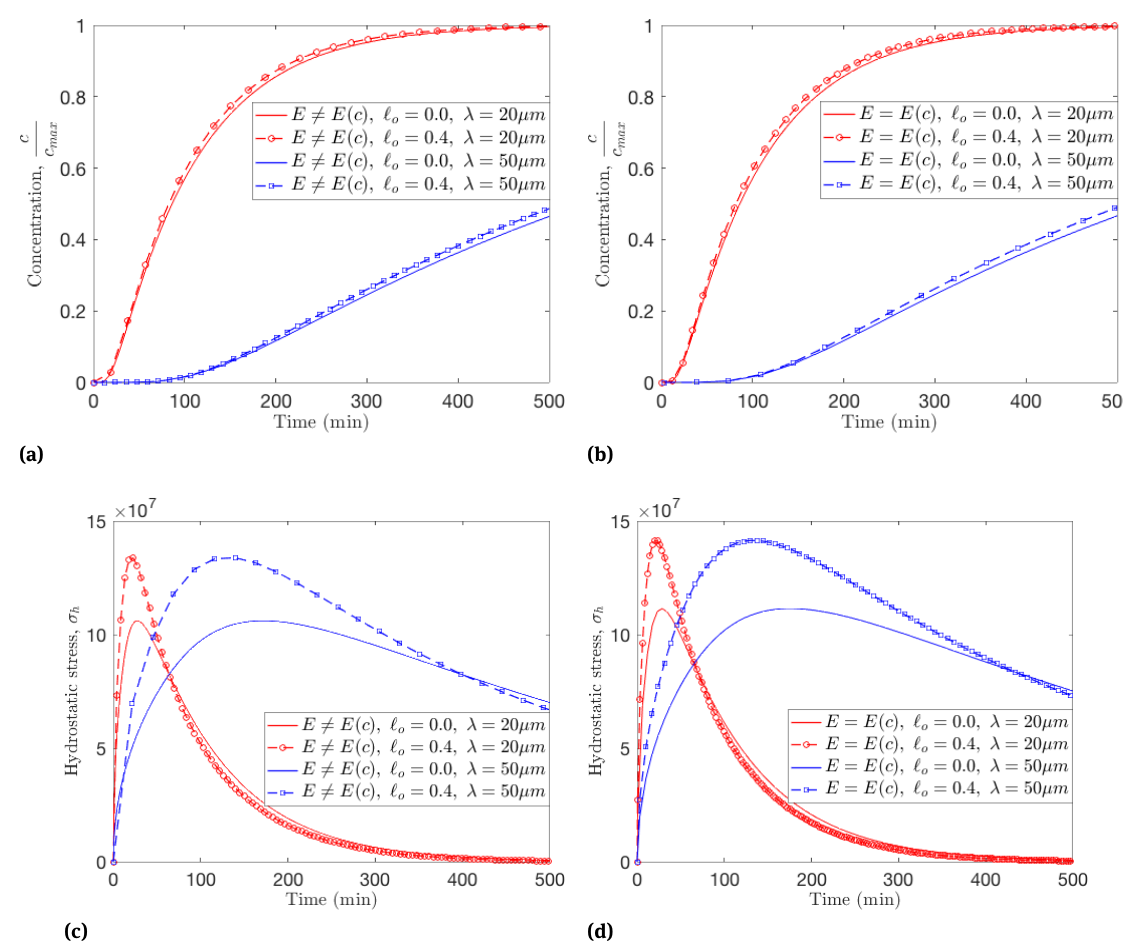
Figure 3: Influence of the particle size, internal length and Young’s modulus on the evolution of (a-b) concentration and (c-d) hydrostatic stress at the center of a spherical